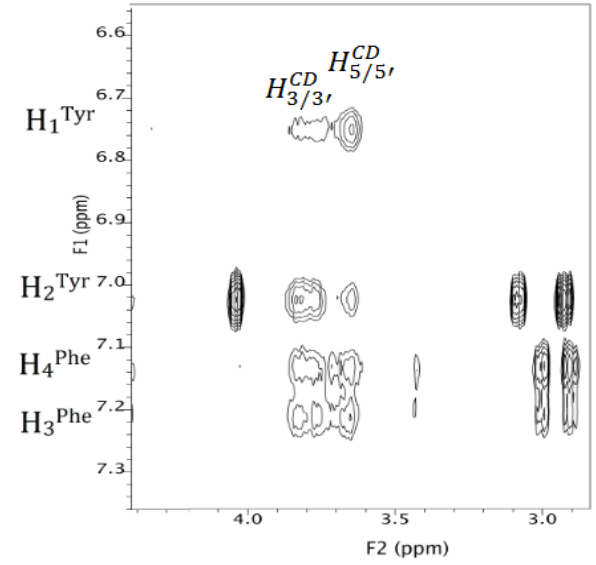
Figure 5. ROESY map (600 MHz, D 2 O, 25 °C, 9.8 mM) of DAL/MCD mixture between 6.6–7.3 ppm and 2.8–4.4